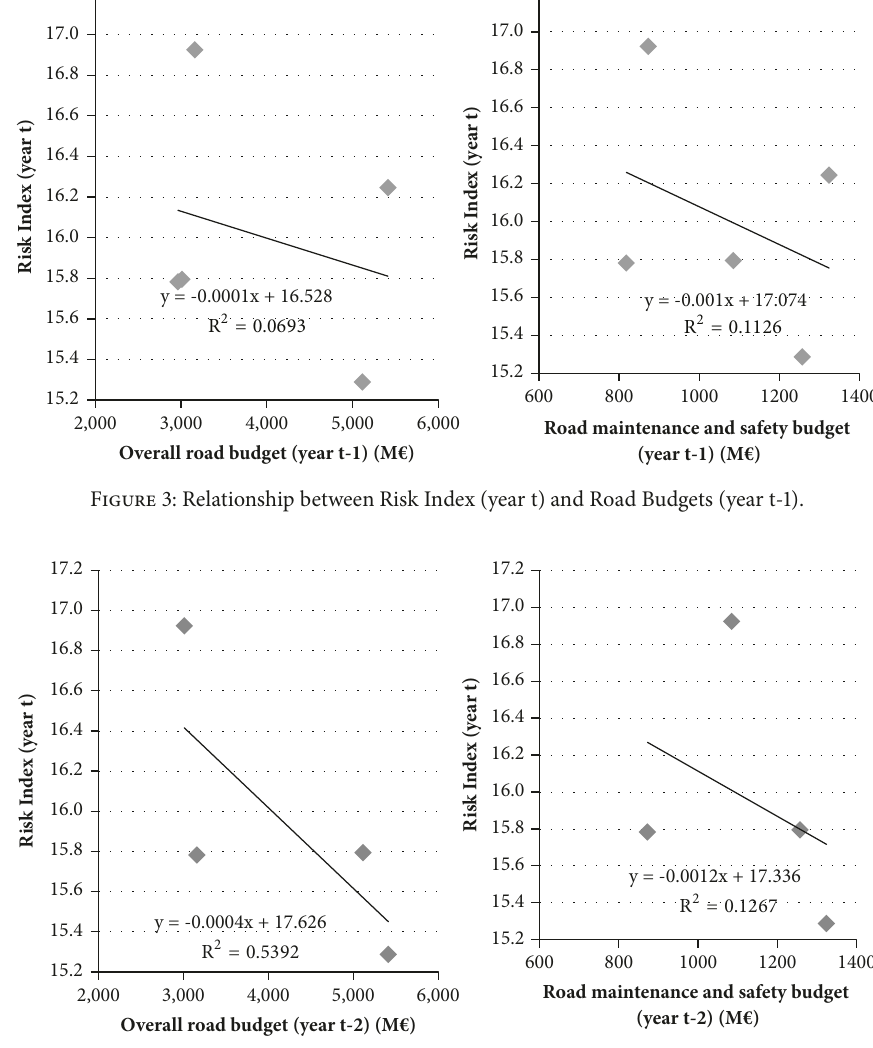
Figure 4: Relationship between Risk Index (year t) and Road Budgets (year